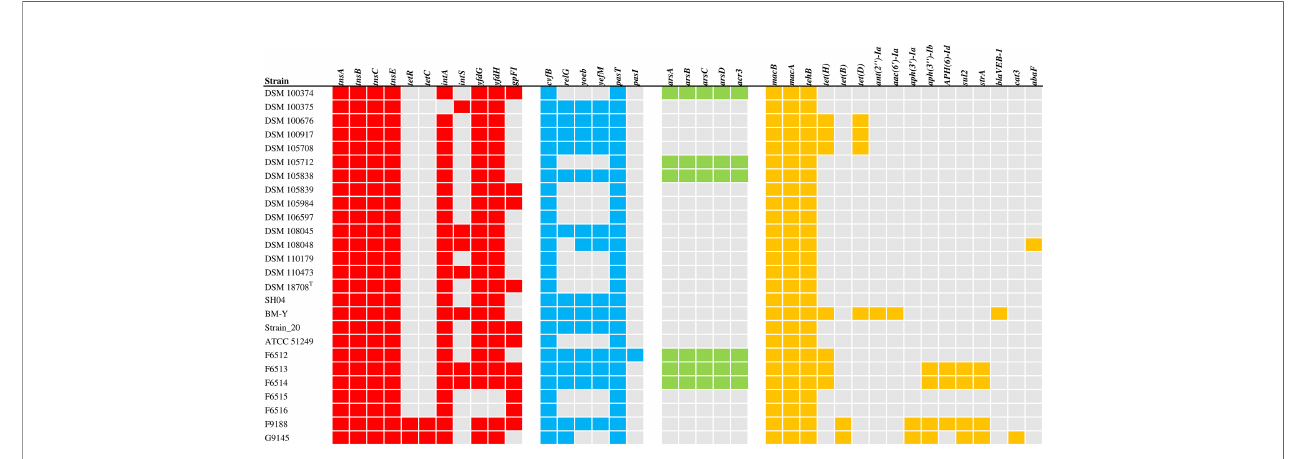
FIGURE 3 | Heat-map visualizing genes derived from mobile genetic elements (red), and genes associated with putative virulence traits (blue), arsenic resistance (green) and antimicrobial resistance (yellow). Cell colors indicate the presence of genes: grey (absence); red, blue, green and yellow